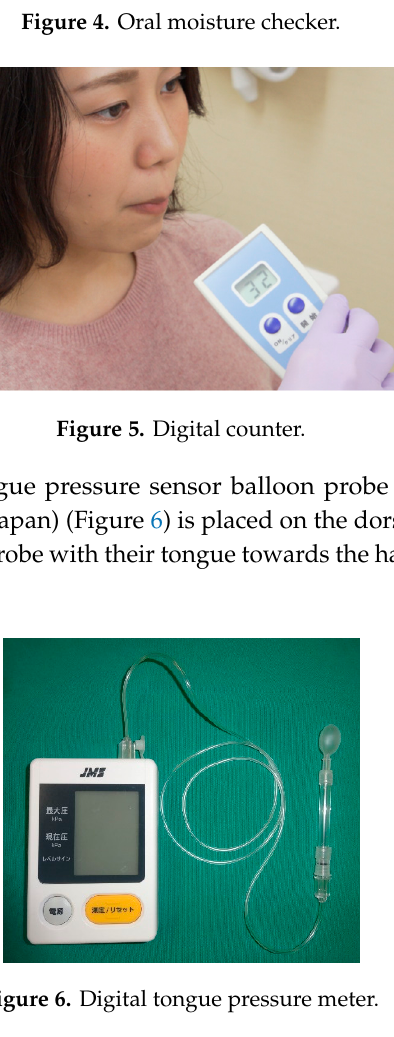
Figure 7 . Masticatory ability testing system